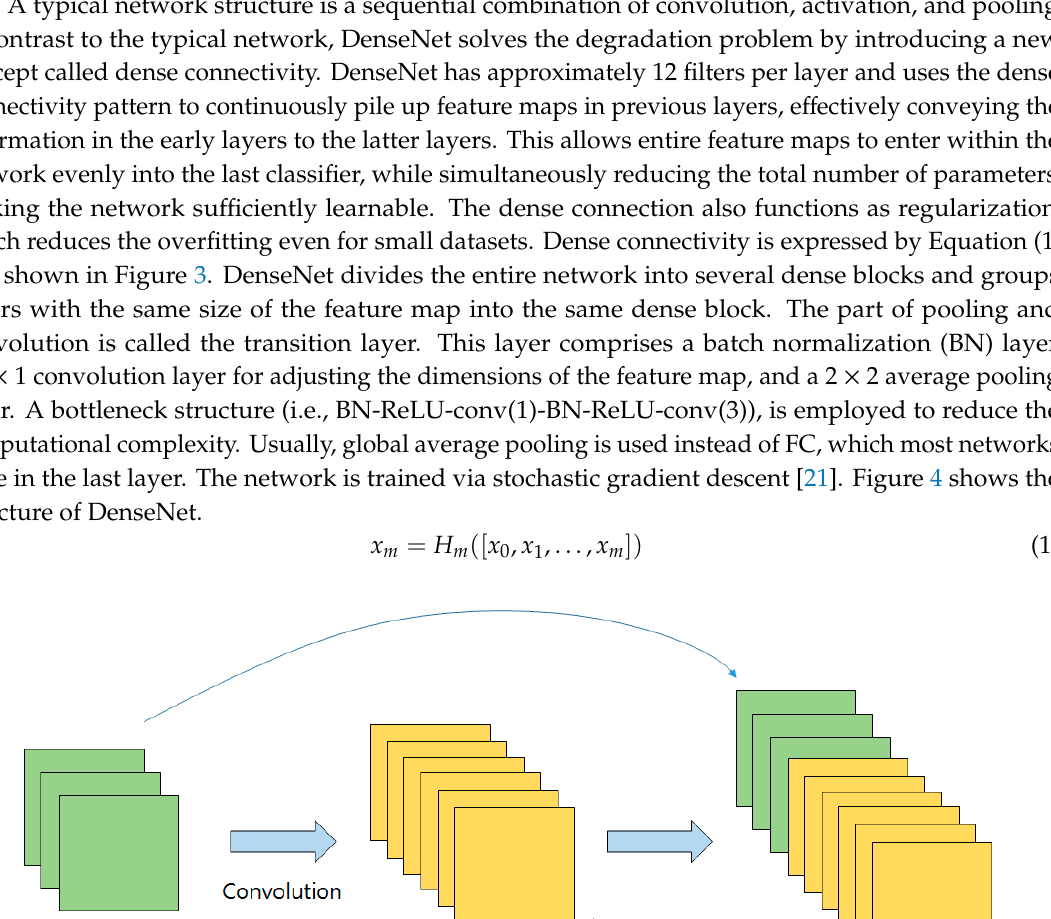
Figure 3. Dense connectivity.